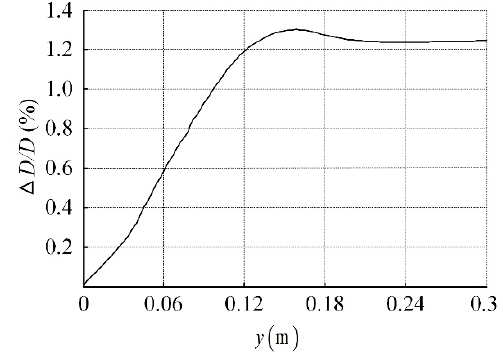
Figure 11. Ovalization change during pipe reeling.